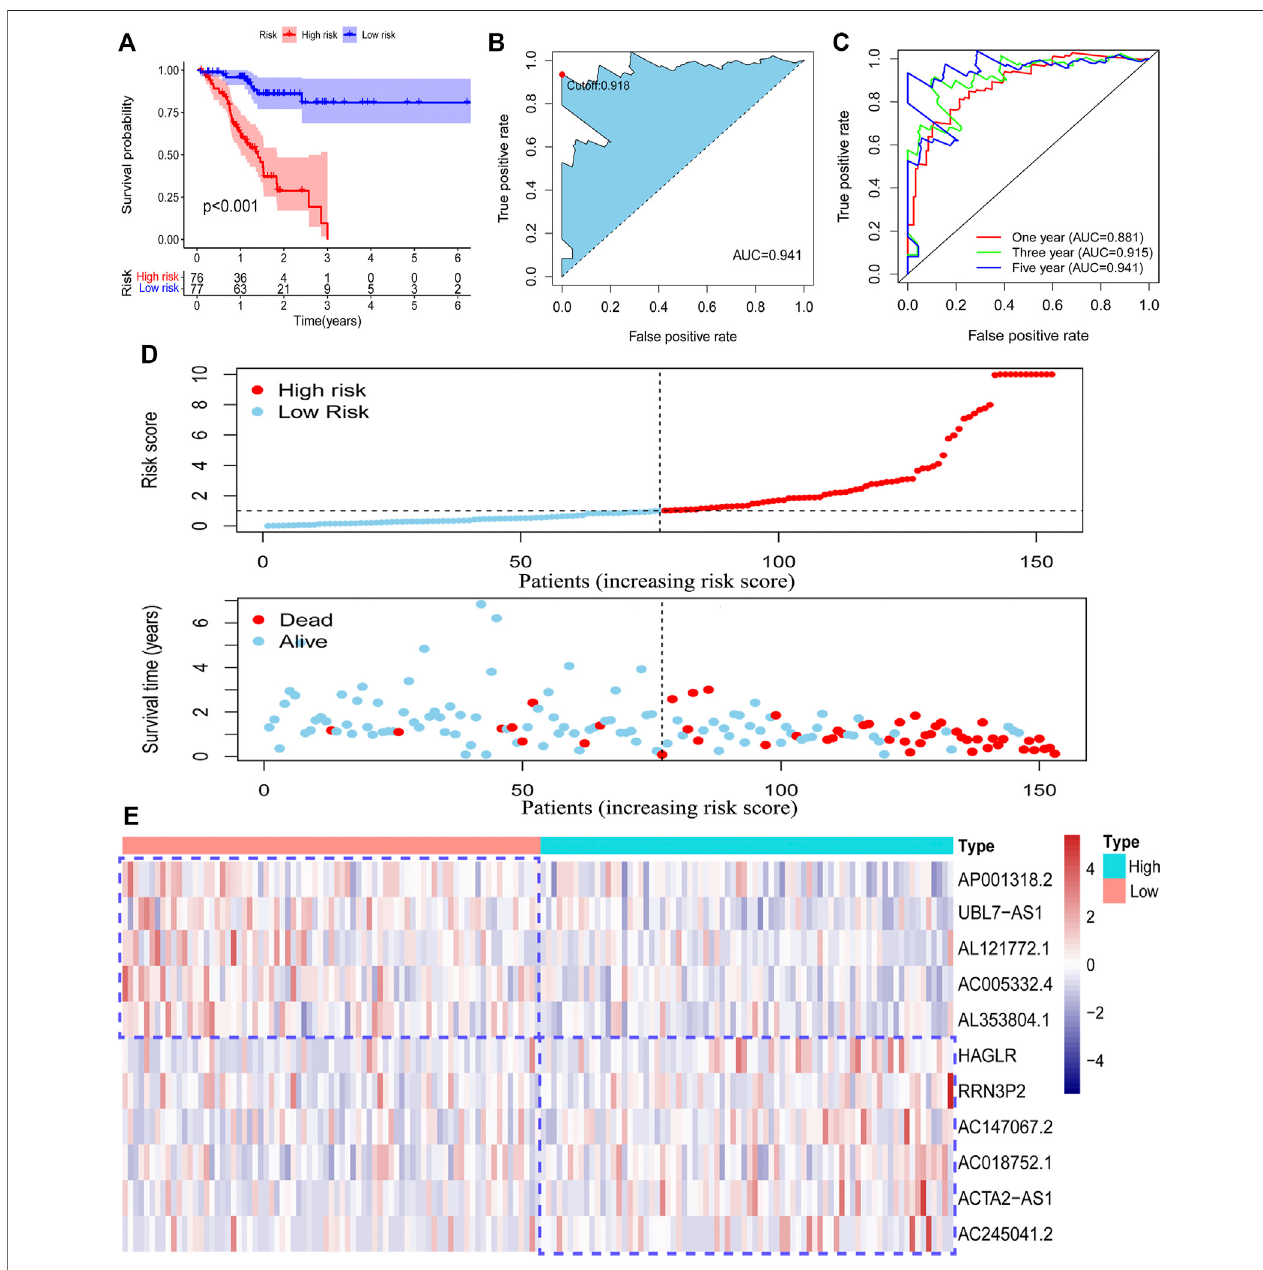
FIGURE3 | Survivalanalysis ofthe riskmodel. The survival difference between thelow-risk patients and high-risk patientsin the training set (A) .A time-dependent ROC curve was plotted to test the accuracy of the risk model (B, C) . Patients in the training set were ranked according to the risk score. Then, the survival status difference of the patients between the two groups was visualized (D) . The RNA level of the 11 pyroptosis-related lncRNAs in the training set was visualized (E) .